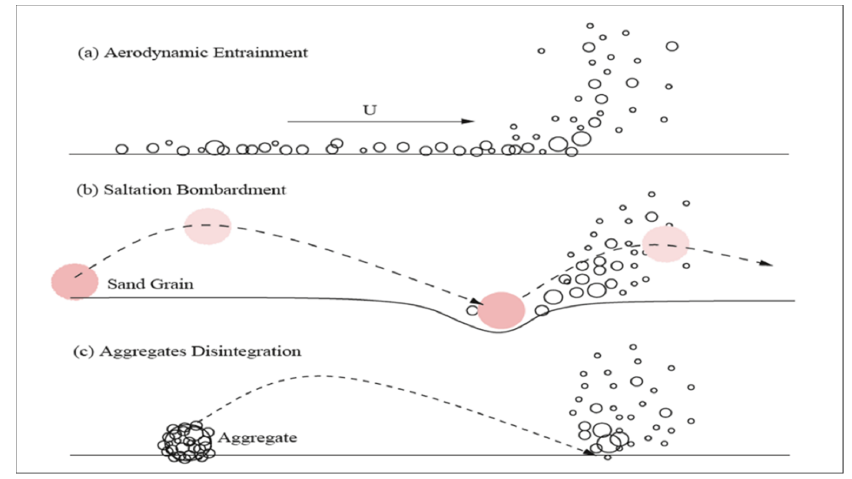
Figure 1. Illustration of the three dust emission mechanisms: ( a ) aerodynamic entrainment, ( b ) ejection of dust aerosols from soil aggregates by impacting saltating particles, and ( c ) ejection of dust aerosols from soil aggregates that are participating in saltation. Adapted from Shao [24].